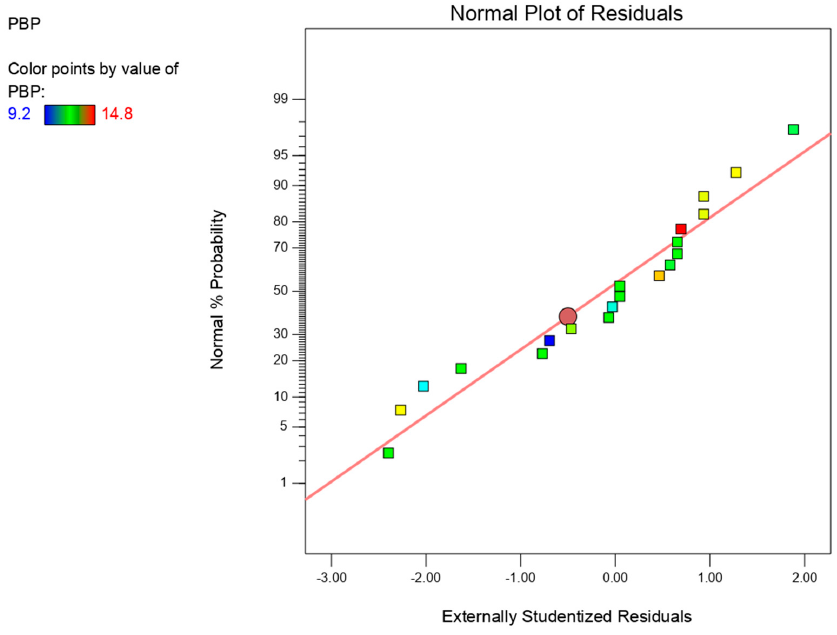
Figure 6. Plot of normal probability of residuals for PBP data.